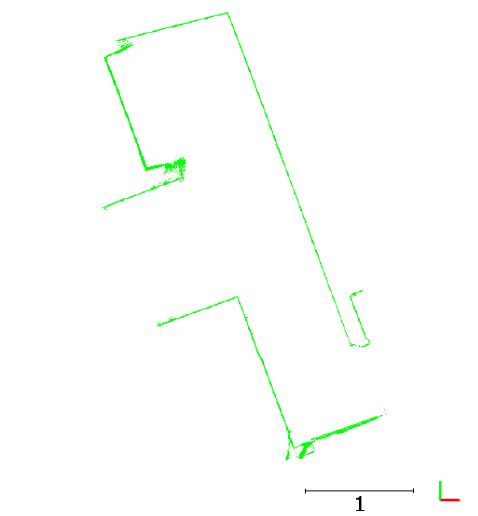
Figure 8. 2D point cloud, segmented out of the TLS point cloud at Crazyflie scanning height, for the ITC dataset